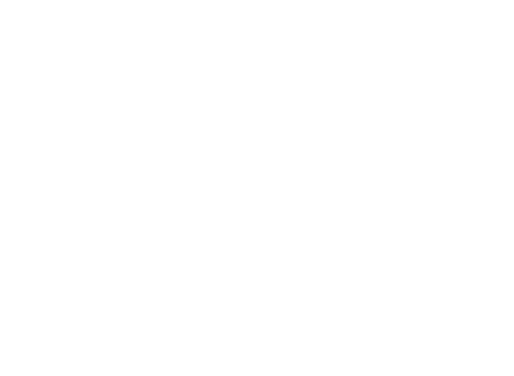
Figure 9. Milrinone levels detected in plasma 24 h post treatment for Groups 2, 3, and 5. The graph shows a representative result of mean ± SD ( n = 3). *** p < 0.001 was considered significant based on Tukey’s post hoc analysis.